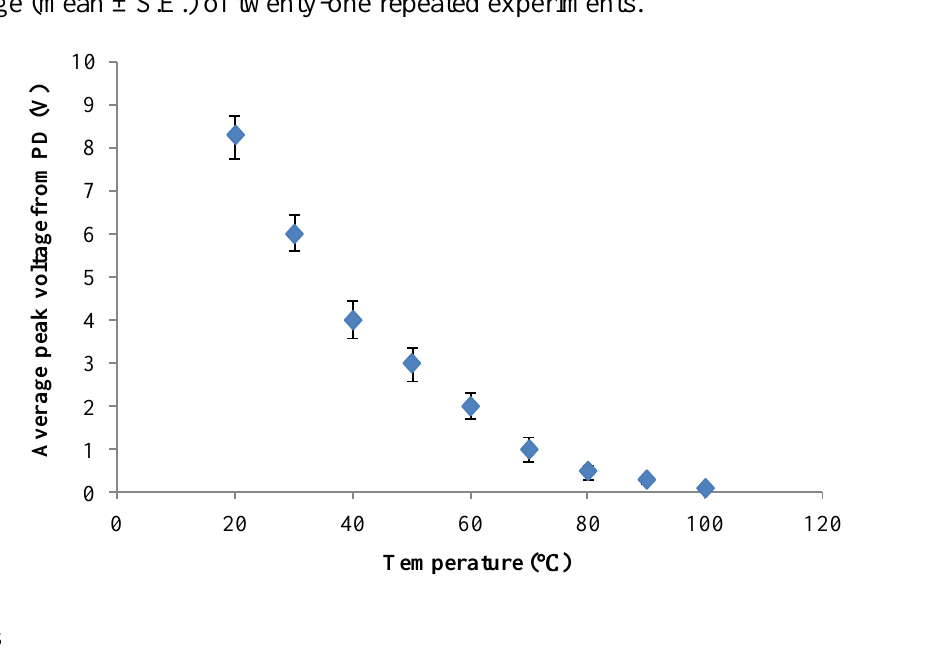
Figure 5. The response of chlorophyll fluorescence intensity of the microalgae cells ( platymonas subcordiformis ) to temperature. The excitation light power is 8 mW. Data are the average (mean ± S.E.) of twenty-one repeated